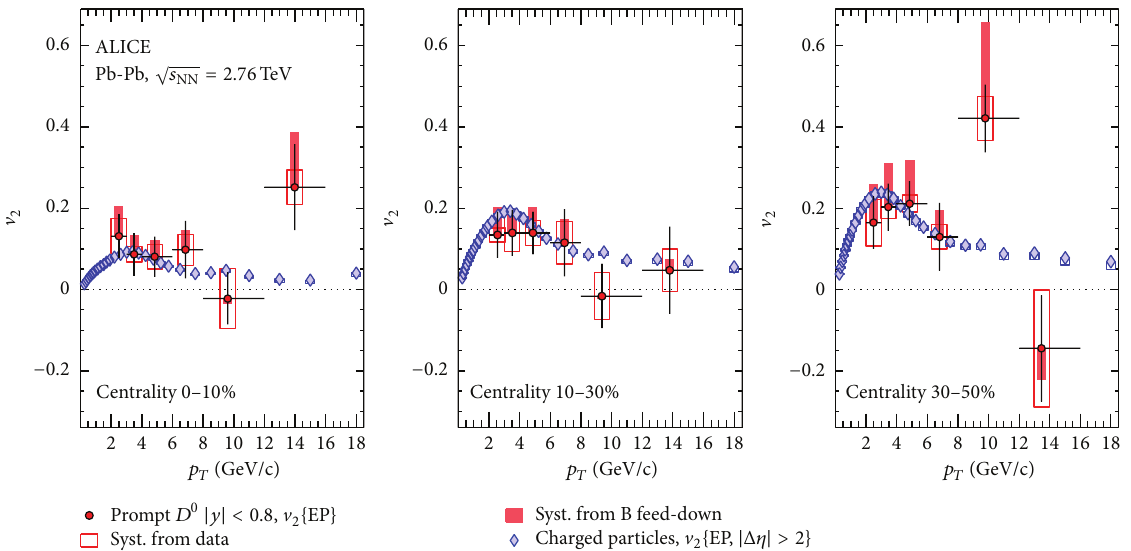
Figure 5: Comparison of 𝐷 0 meson [30] and charged-particle [31] V 2 in three centrality classes as a function of 𝑝 𝑇 . The vertical error bars represent the statistical uncertainty; the open boxes are the systematic uncertainties.